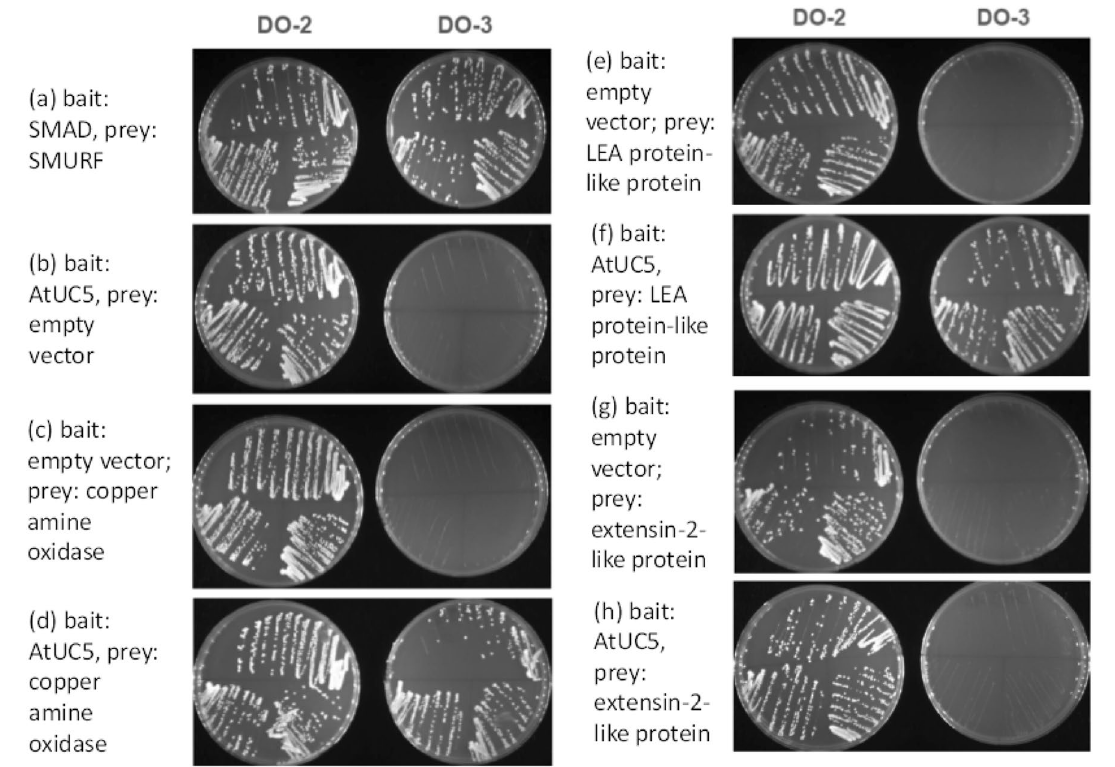
Figure 4. Characterising protein–protein interactions between AtUC5 and various proteins by pairwise yeast two-hybrid analysis. DO-2 indicates media without tryptophan and leucine, which selects for yeast containing both bait and prey plasmids. DO-3 indicates media without tryptophan, leucine, and histidine, which selects for yeast containing both bait and prey plasmids, and a protein–protein interaction between the bait and prey proteins. ( a ) Positive control (bait: SMAD, prey: SMURF). ( b ) Negative control (bait: AtUC5, prey: empty vector). ( c ) Negative control (bait: empty vector; prey: copper amine oxidase). ( d ) Protein–protein interaction (bait: AtUC5, prey: copper amine oxidase). ( e ) Negative control (bait: empty vector; prey: LEA protein-like protein). ( f ) Protein–protein interaction (bait: AtUC5, prey: LEA protein-like protein). ( g ) Negative control (bait: empty vector; prey: extensin-2-like protein). ( h ) Protein–protein interaction (bait: AtUC5, prey: extensin- 2-like protein). SMAD, SMURF: interacting proteins in the human TGF-β/Smad